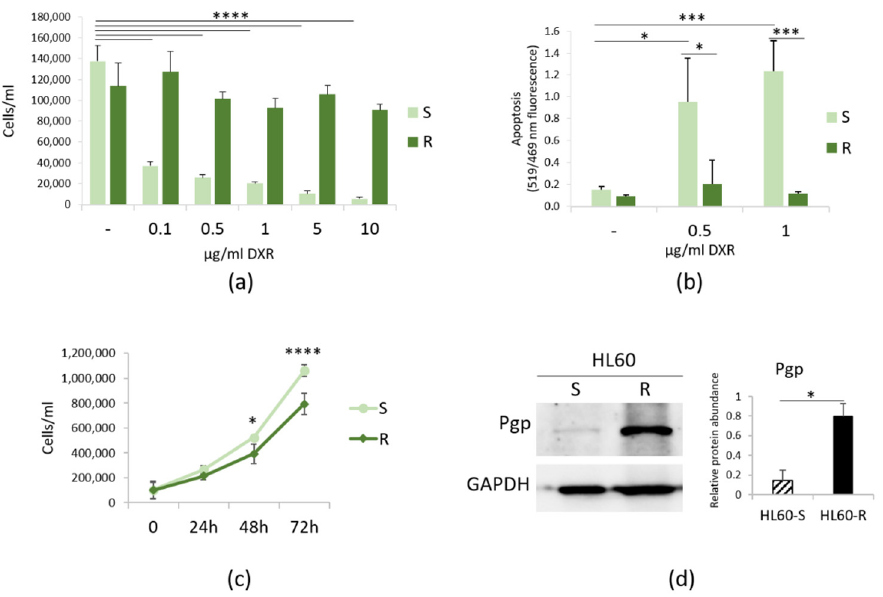
Figure 1. Characterization of HL60-R. ( a ) HL60-S and -R were cultured in the presence of different concentrations of DXR and counted after 24 h. ( b ) TUNEL assay was performed on HL60-S and -R treated for 24 h with DXR (0.5 and 1 µg/ml). ( c ) HL60-S and -R were cultured for 24, 48 and 72 h in their culture medium and counted every 24 h. ( d ) Western blot was performed on protein lysates using antibodies against Pgp. GAPDH was used as control of loading. A representative blot and densitometry obtained by ImageJ on three independent experiments ± SD are shown. * p < 0.05; *** p < 0.001; **** p < 0.0001.